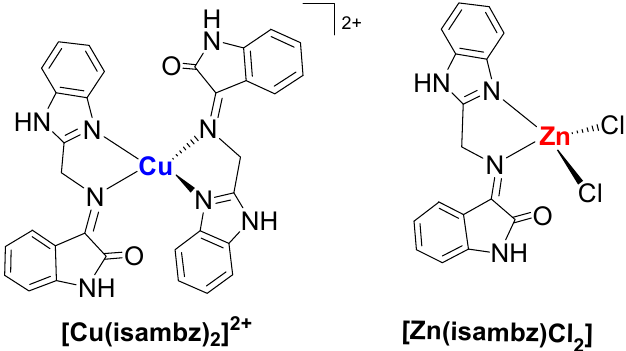
Figure 1. Scheme of the studied complexes, [Cu(isambz) 2 ] 2+ 1 , and [Zn(isambz)] 2+ 2 .